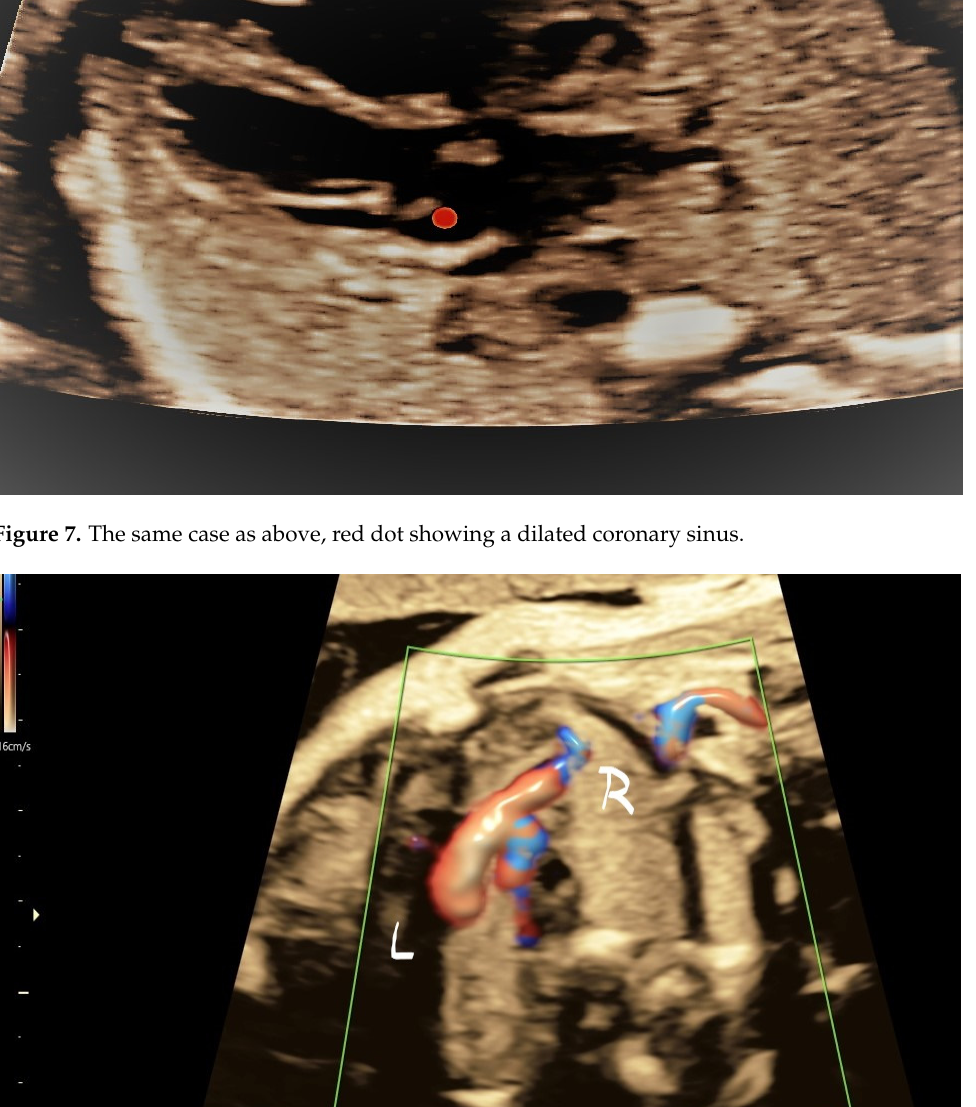
Figure 7. The same case as above; inverted flow in the innominate vein. Figure 8. The same case as above; inverted flow in the innominate